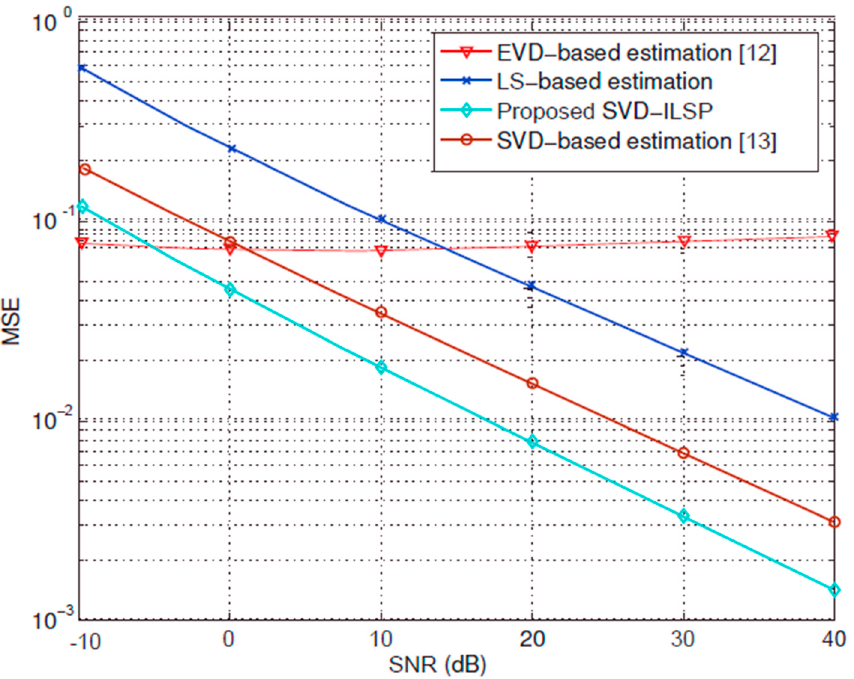
Figure 3. Mean Square Error (MSE) comparison of algorithms under different SNR conditions.